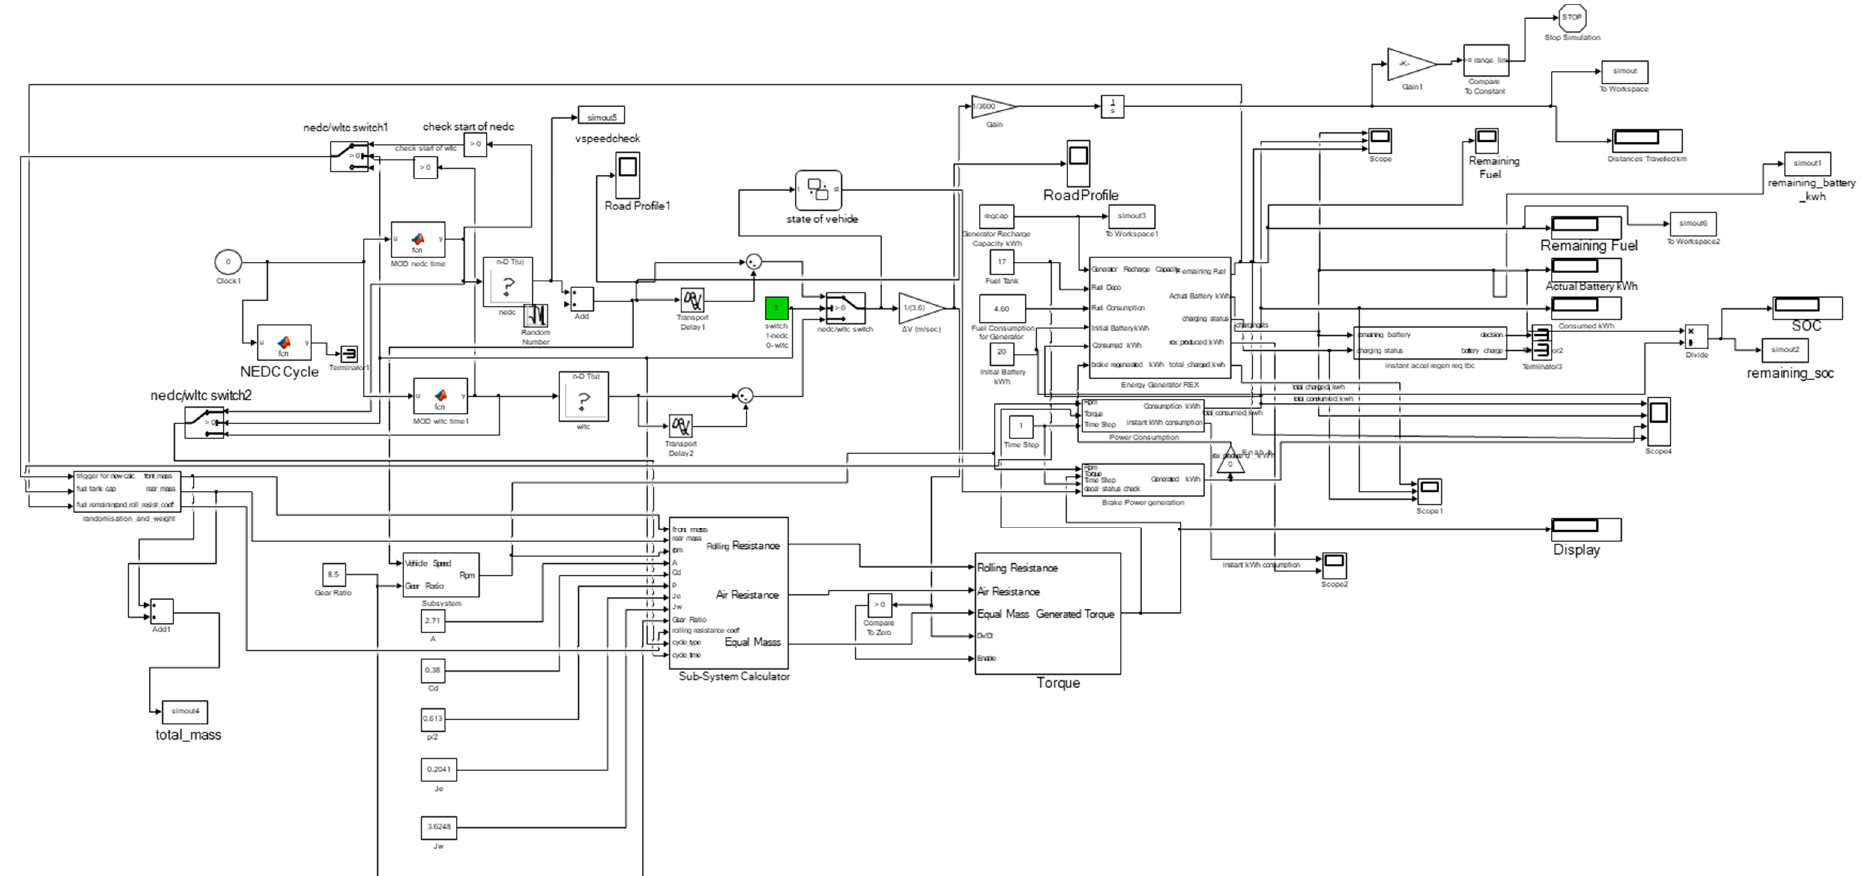
Figure 12. REX vehicle simulation model.